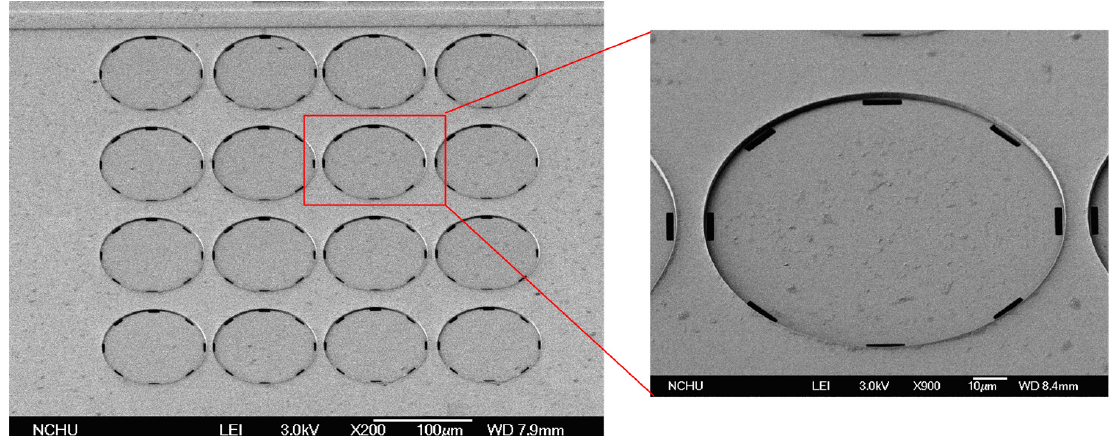
Figure 13. SEM image of the FET pressure sensor after the wet etching